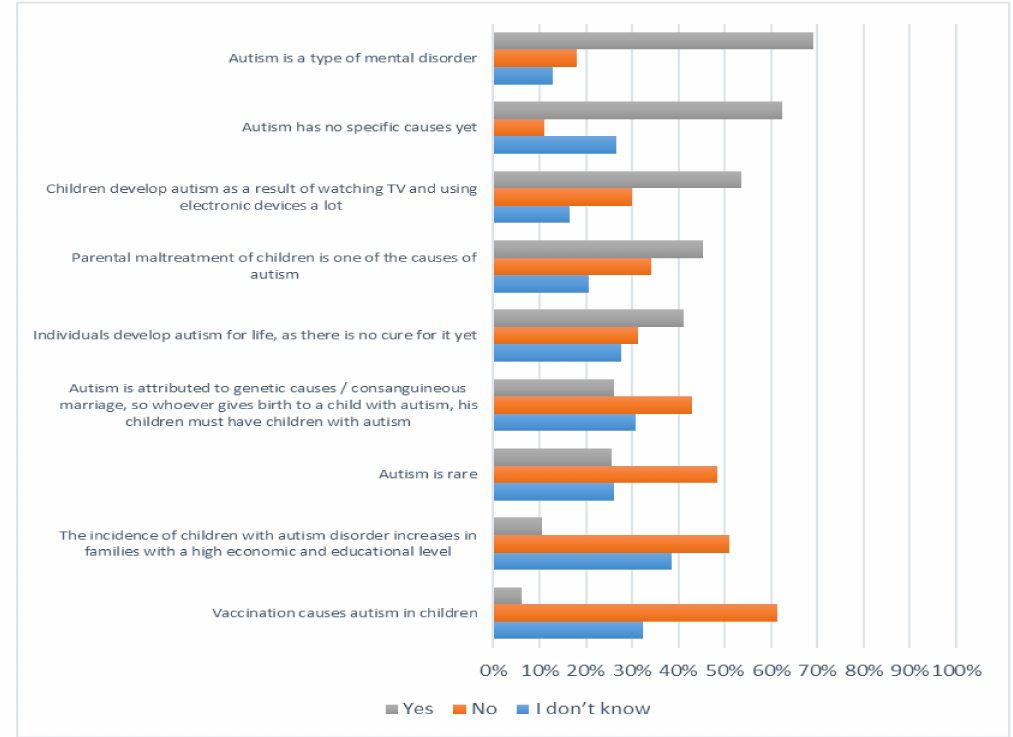
Figure 1. The level of knowledge of the causes of autism